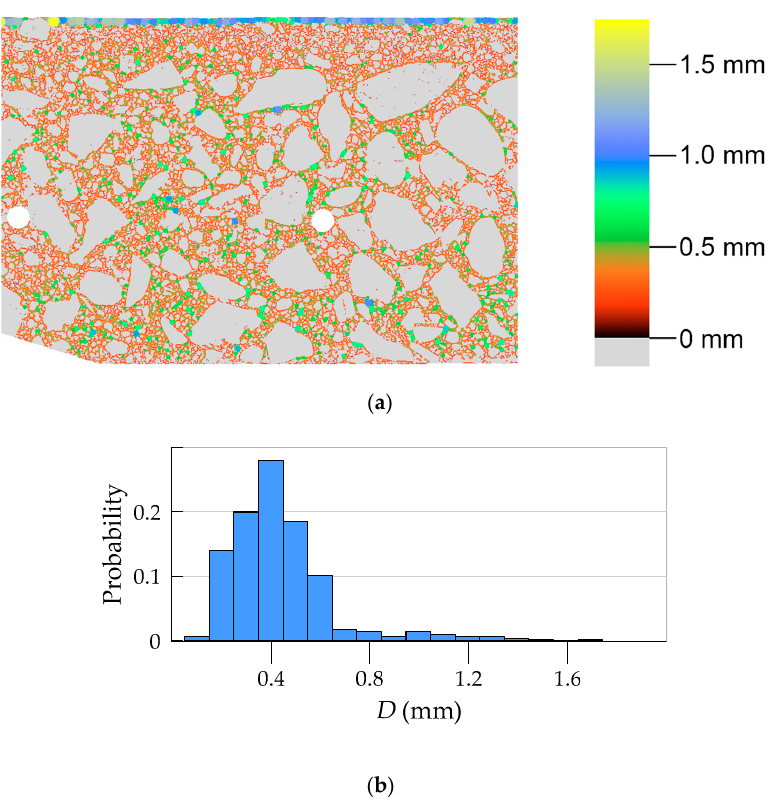
Figure 13. Local thickness of cement matrix: ( a ) contour map (limited to ROI); ( b ) histogram.